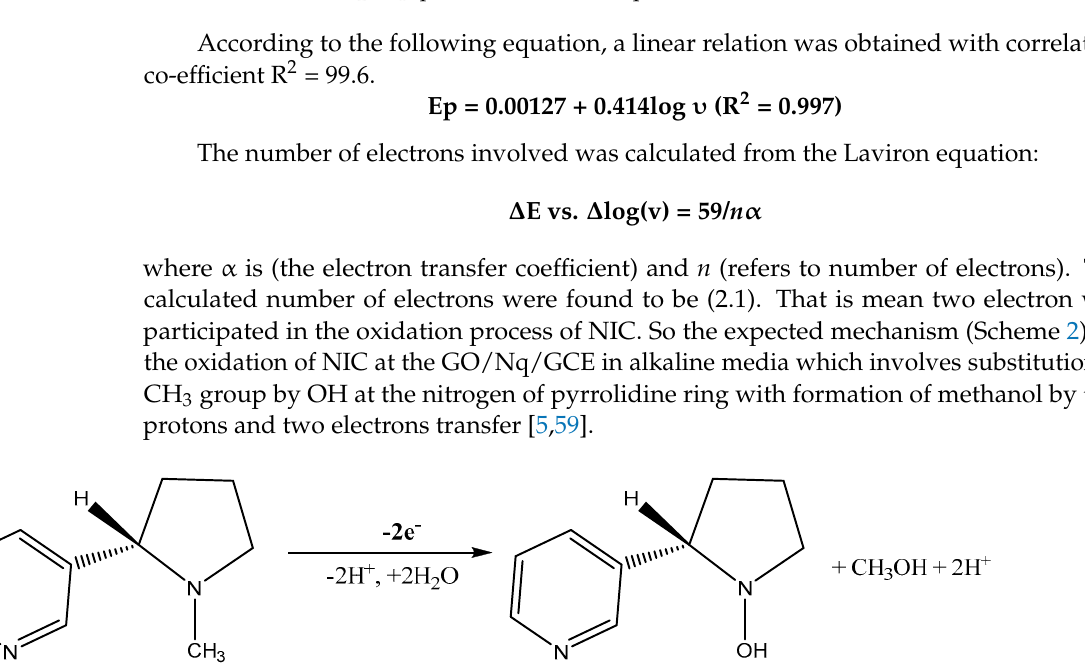
Figure 10. ( a ) The relation between oxidation peak potential of 3.5 mM of NIC in 0.1 M of Na 2 SO 4 (pH 8.0) at the GO/Nq/GCE versus Log scan rate. ( b ) The relation between peak current of 3.5 mM of NIC in 0.1 M of Na 2 SO 4 (pH 8.0) at the GO/Nq/GCE versus scan rate.